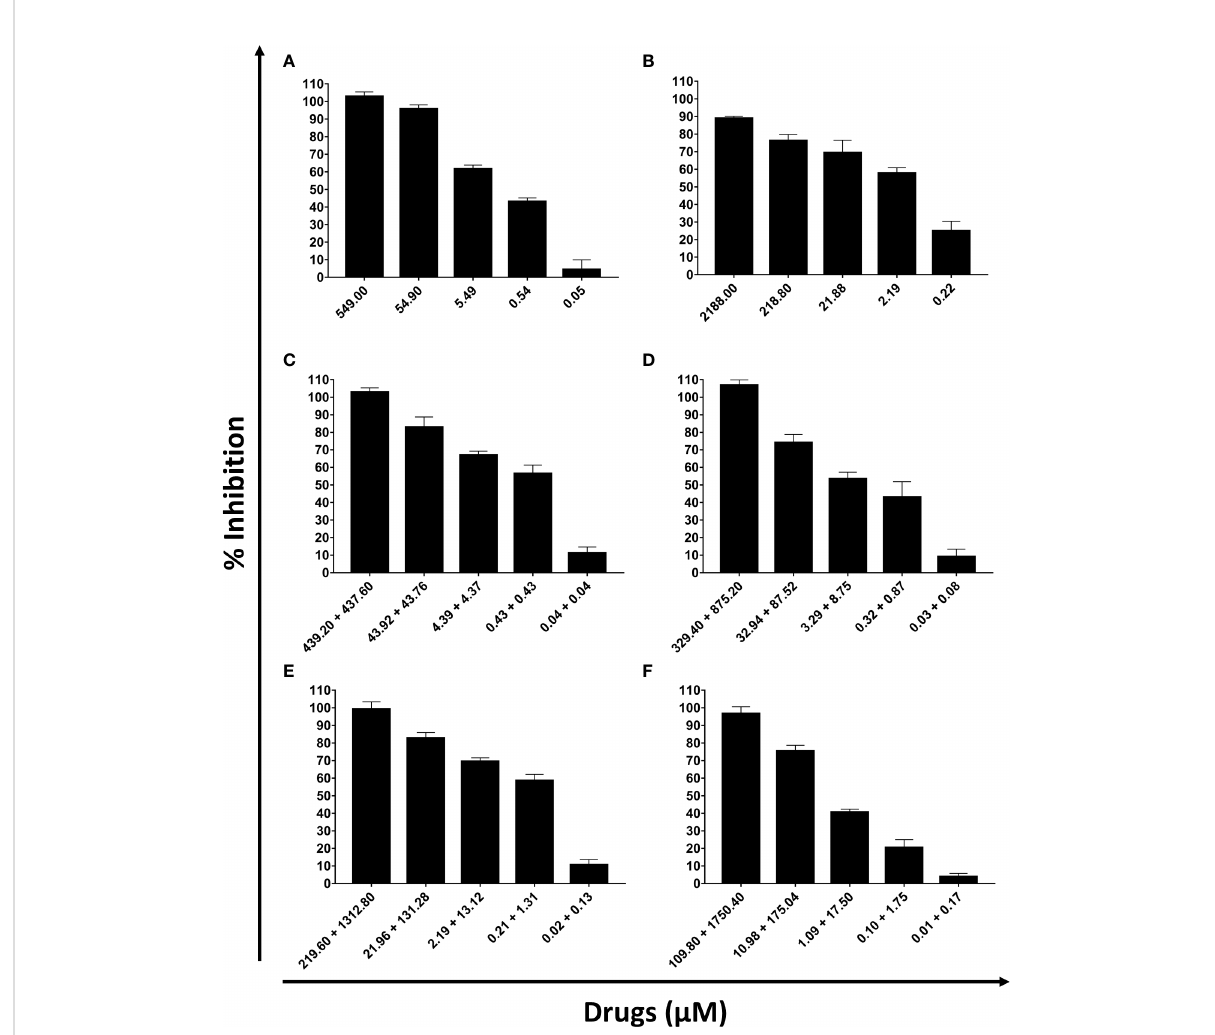
FIGURE 1 Evaluation of the activity of sodium diethyldithiocarbamate (DETC) and benznidazole (BZ) in the in vitro proliferation of Trypanosoma cruzi epimastigote forms (10 7 parasites/mL, Y strain). The proportions of the combinations were: 5 x IC 50 DETC (A) ; 5 x IC 50 BZ (B) , 4 x IC 50 DETC +